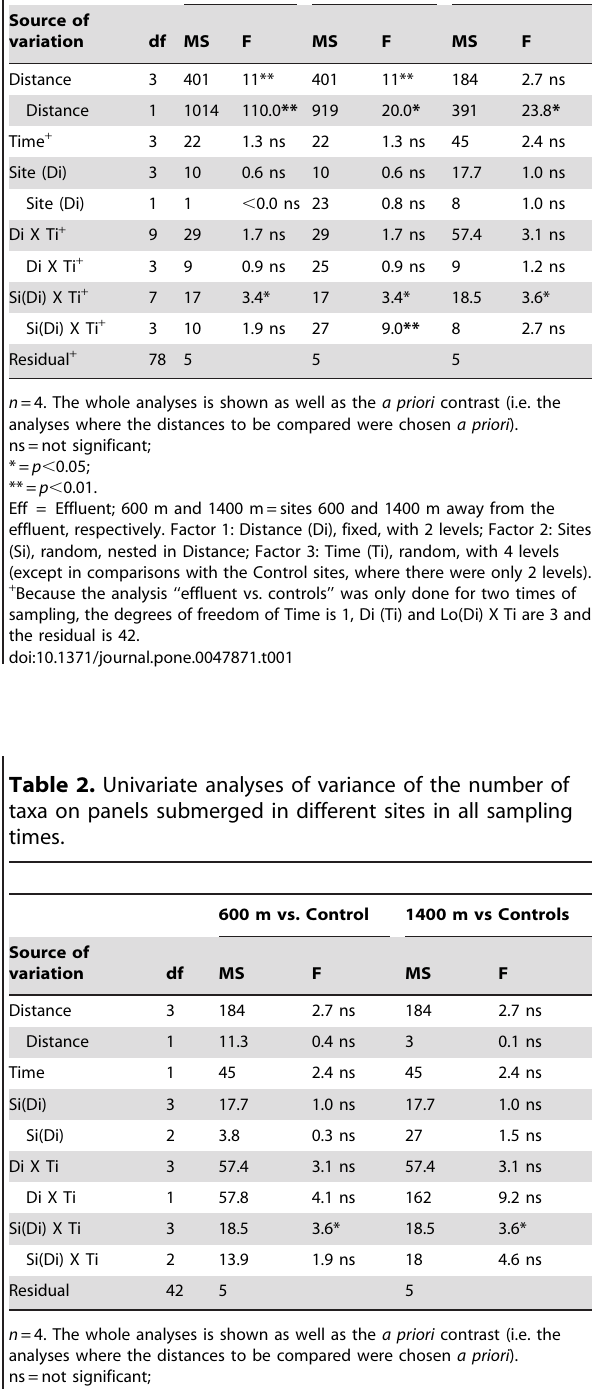
Residual n =4. The whole analyses is shown as well as the a priori contrast (i.e. the analyses where the distances to be compared were chosen a priori ). ns=not significant; *= p , 0.05; Factor 1: Distance (Di), fixed, with 2 levels; Factor 2: Sites (Si), random, nested in Distance with 4 levels; Factor 3: Time (Ti), random, with 2